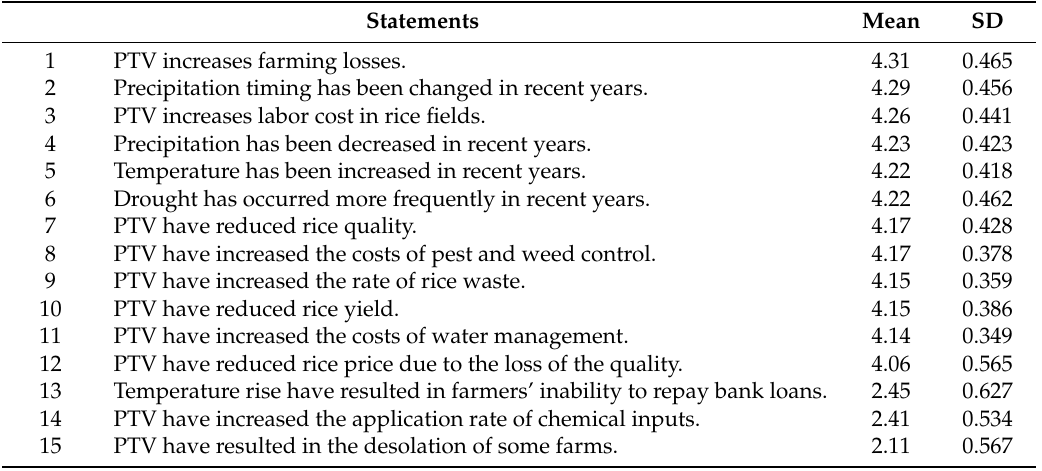
Table 4. Paddy farmers’ perception towards precipitation and temperature variability